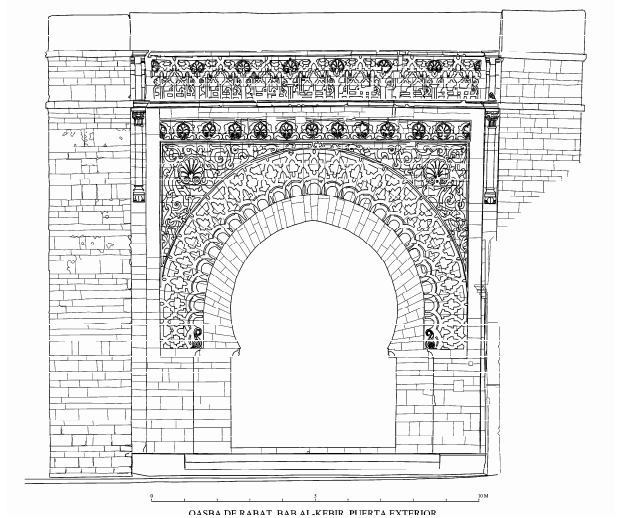
Figure 6. Elevations and 3D model of the western pavillion of al-Badi palace in Marrakech.